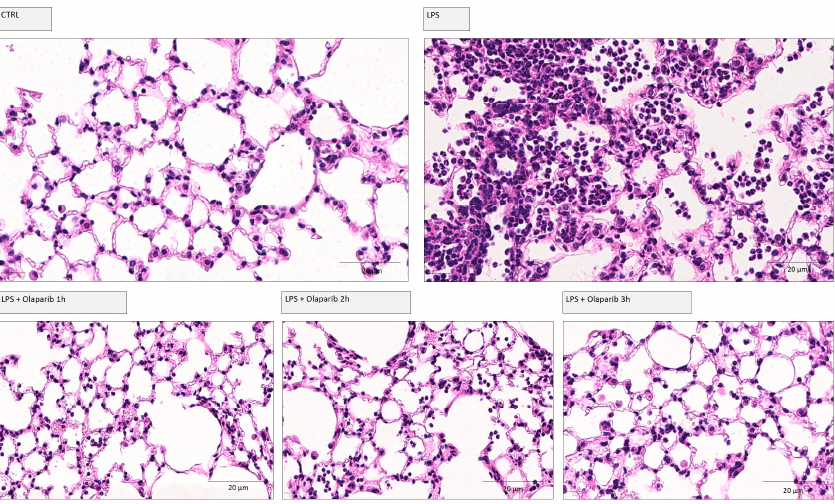
Figure 18. Effect of olaparib post-treatment on lung histology in a murine model of ALI. C57Bl/6 mice received either PBS (30 µL) or LPS (50 µg in 30 µL PBS) by intratracheal instillation in the absence or presence of 10 mg/kg olaparib delayed to 1, 2, or 3 h post-LPS. After 24 h, lung tissues were analyzed histologically. Representative histological pictures are shown. Please note the increased cell infiltration and inflammation after LPS and the improvement by olaparib in the LPS-treated animals. Olaparib also remained effective in terms of reducing pulmonary extravasation and inhibiting neutrophilia in the BAL (Figure